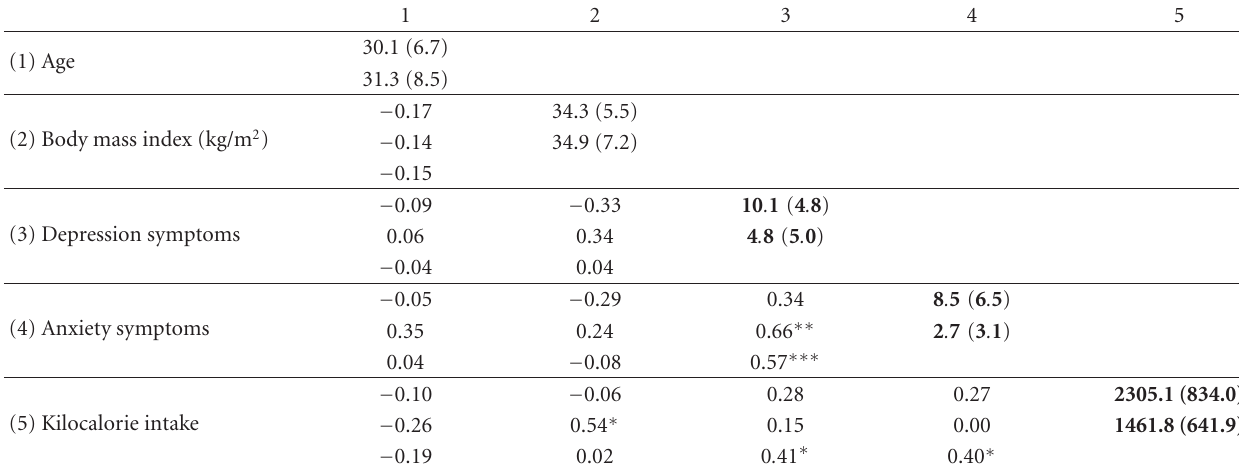
Table 1: Group means and intercorrelations for study variables.